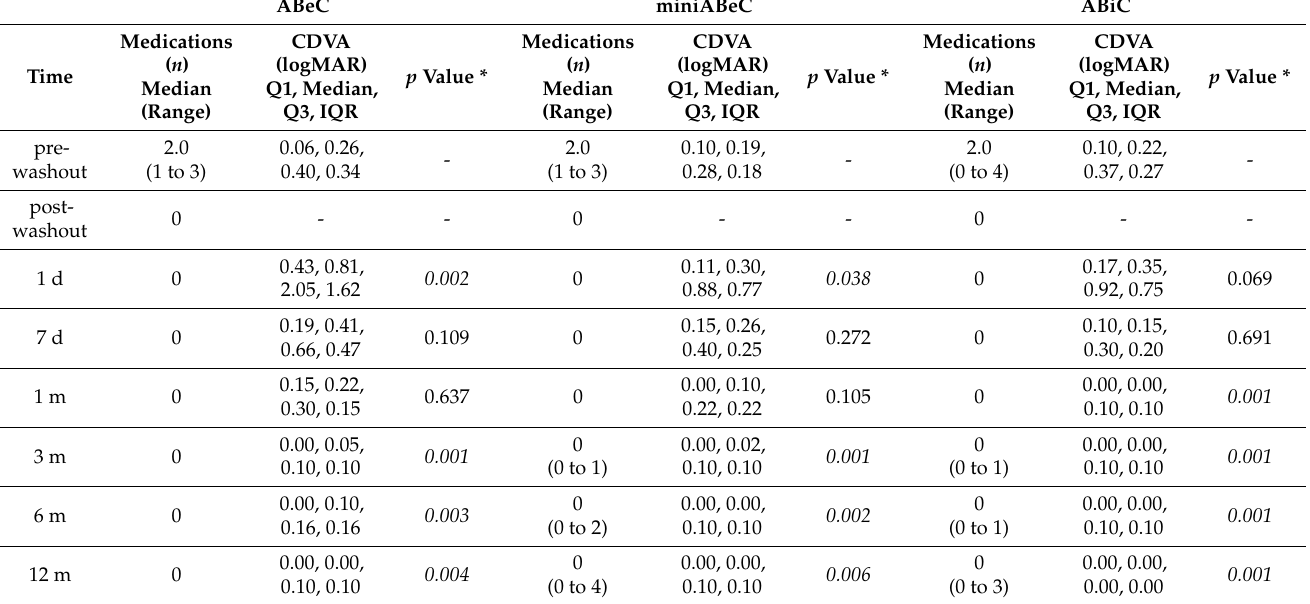
Table 3. First quartiles (Q1), medians, third quartiles (Q3) and interquartile ranges (IQRs) of CDVA and number of medications ( n ) at each time stage before and after surgery in three groups of patients: ab externo canaloplasty (ABeC), minicanaloplasty (miniABeC) and ab interno canaloplasty (ABiC). p value * corresponds to the results of the Wilcoxon signed-rank tests for CDVA between particular study stages and the pre-washout stage. All patients in each group completed a 12-month follow-up. Italicized values indicate p <